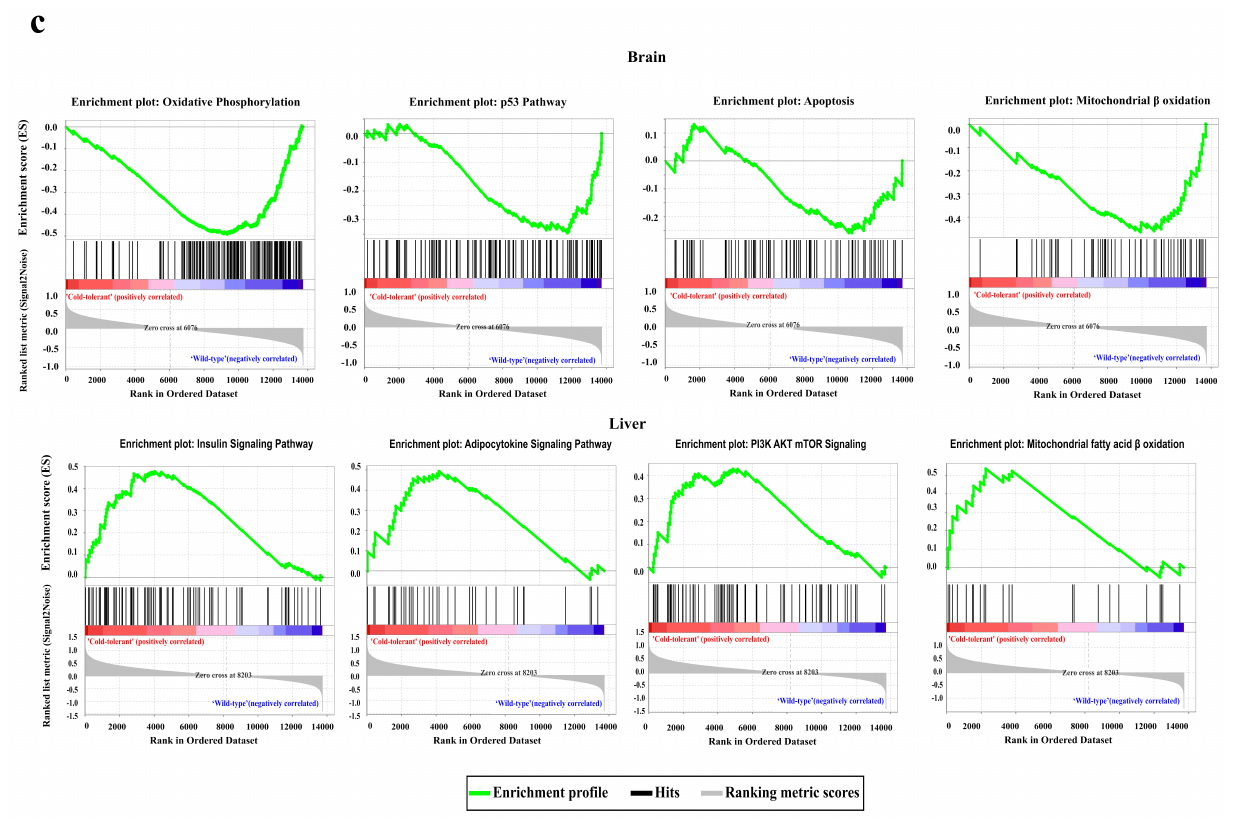
Figure 3. Comparing brain and liver activation-related gene expressions between wild-type and cold-tolerant fugu under cold stress. ( a , b ) Analyses of gene expression of the GSEA for brain (top) and liver (bottom) under cold stress. ( c ) Genesets enriched the FDR < 0.05 pathways: oxidative phosphorylation (NES = − 2.27), p53 (NES = − 1.51), apoptosis (NES = − 1.08), mitochondrial fatty acid β oxidation (NES = − 1.81) in brain. Insulin signaling (NES = 1.52), adipocytokine (NES = 1.45), PI3K AKT mTOR (NES = 1.36), mitochondrial fatty acid β oxidation (NES = 1.45) in liver; NES, normalized enrichment score. FDR, false discovery rate. Positive and negative NES indicate higher and lower expression in the brain and liver,